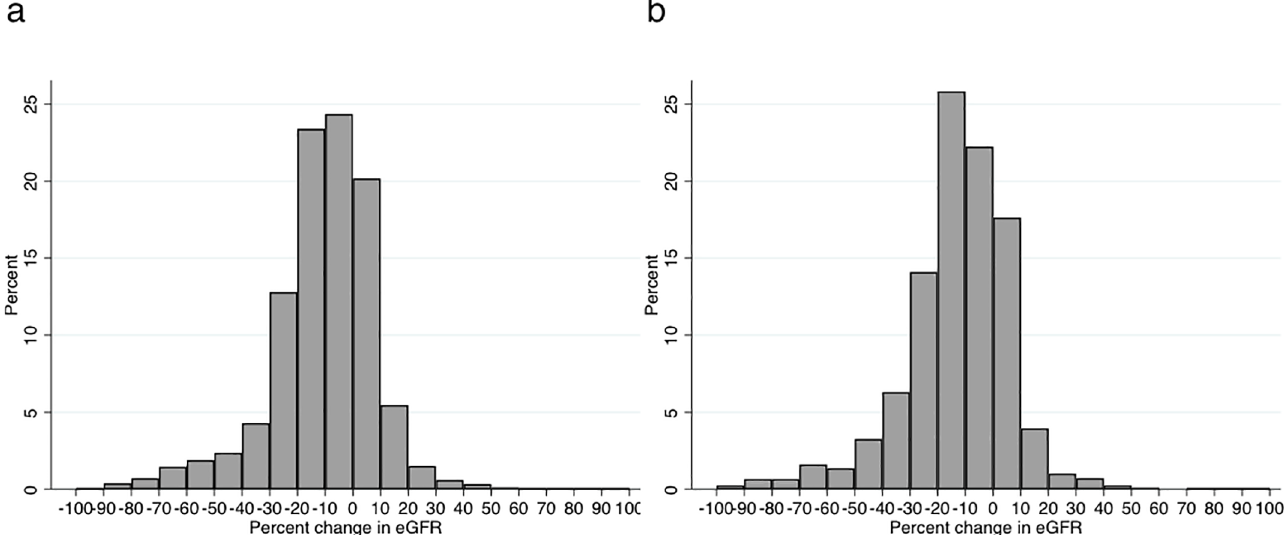
Fig 1. Distribution of percent changes in eGFR during the (a) 2-year or (b) 3-year baseline period. Percent change in eGFR was calculated as (last eGFR at baseline period–first available eGFR) / (first available eGFR) (cid:3) 100.